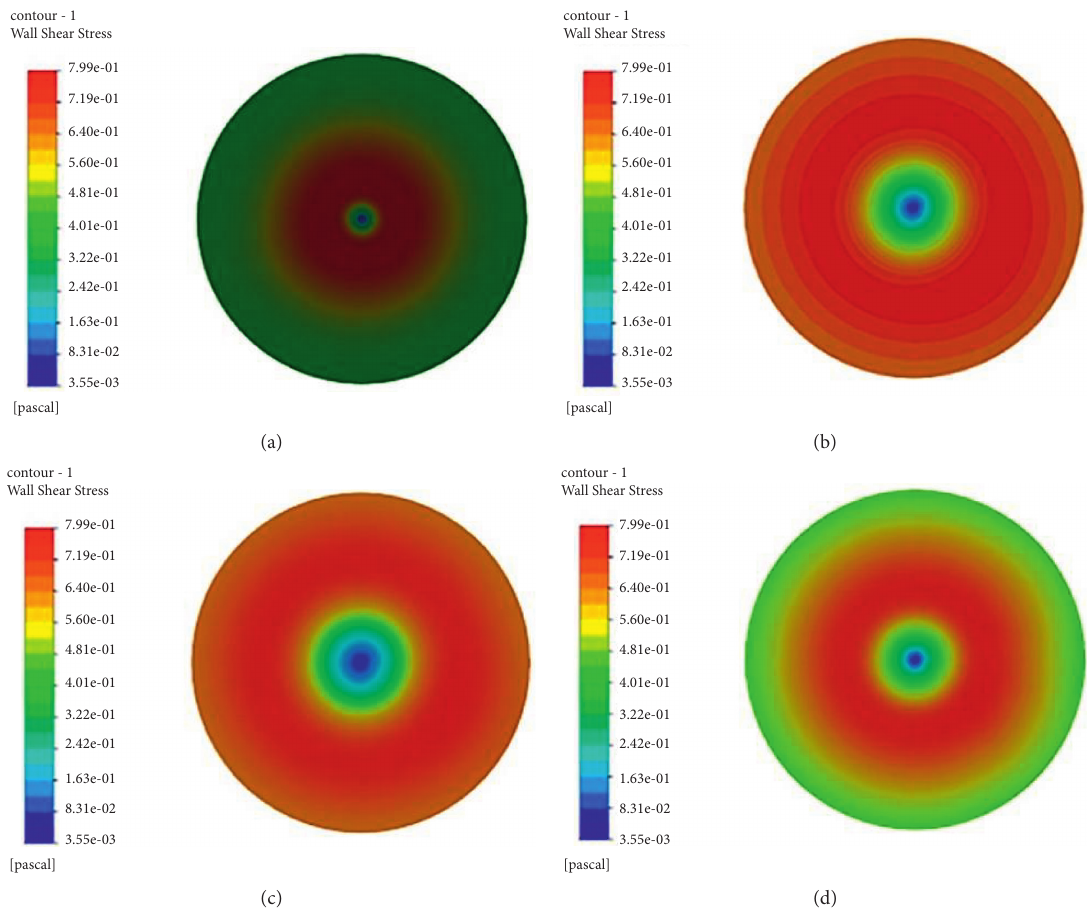
Figure 10: The results of the shear force distribution with different spraying distances. (a) The shear force distribution with spraying distances of 300mm. (b) The shear force distribution with spraying distances of 400mm. (c) The shear force distribution with spraying distances of 500mm. (d) The shear force distribution with spraying distances of